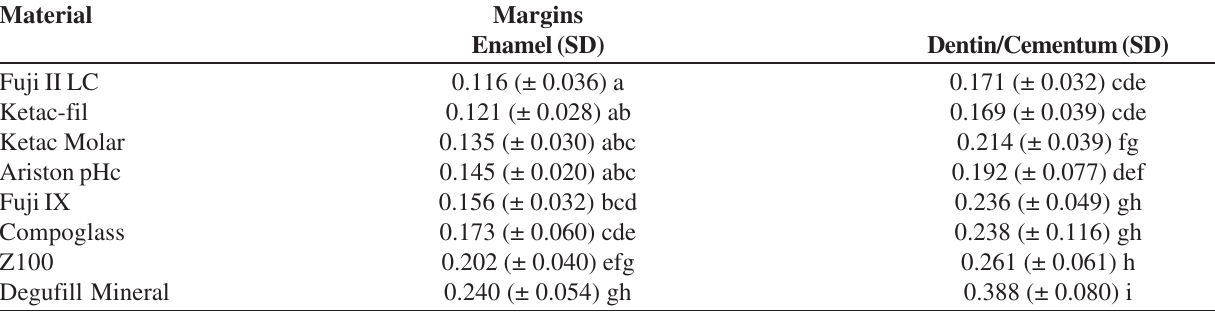
Table 2. Means and standard deviation (SD) of demineralization depth (mm) at enamel and dentin/cementum margins of restorations with the tested